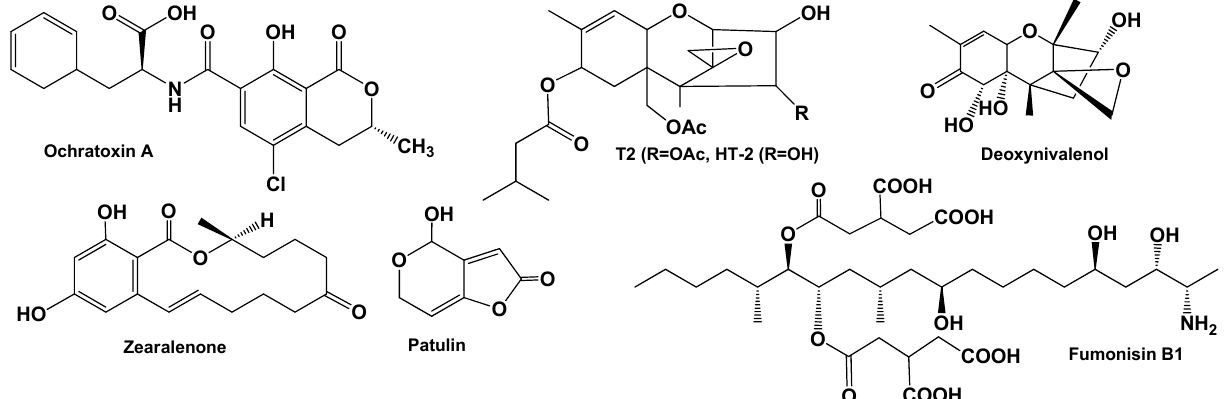
Figure 2. Chemical structure of ochratoxin A, trichothecene mycotoxins, patulin, fumonisin B1, and zearalenone. Fumonisins are produced in cereals, usually by Fusarium verticillioides, Fusarium prolif- eratum , and other related species [47]. Their major influence on human health is caused by more than 15 fumonisin homologues which are mostly associated with contaminated maize, maize-based products as well as rice, wheat, barley, rye, oat, and grain [48]. Fumonisin B1 (Figure 2) is the most abundant. Together with fumonisin B2 and B3 (C-5 and